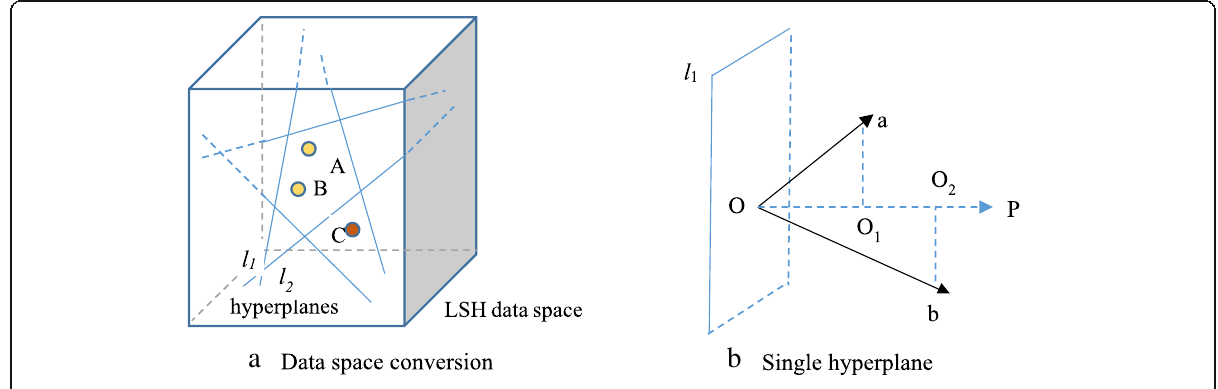
Fig. 2 a , b Rationale of locality-sensitive